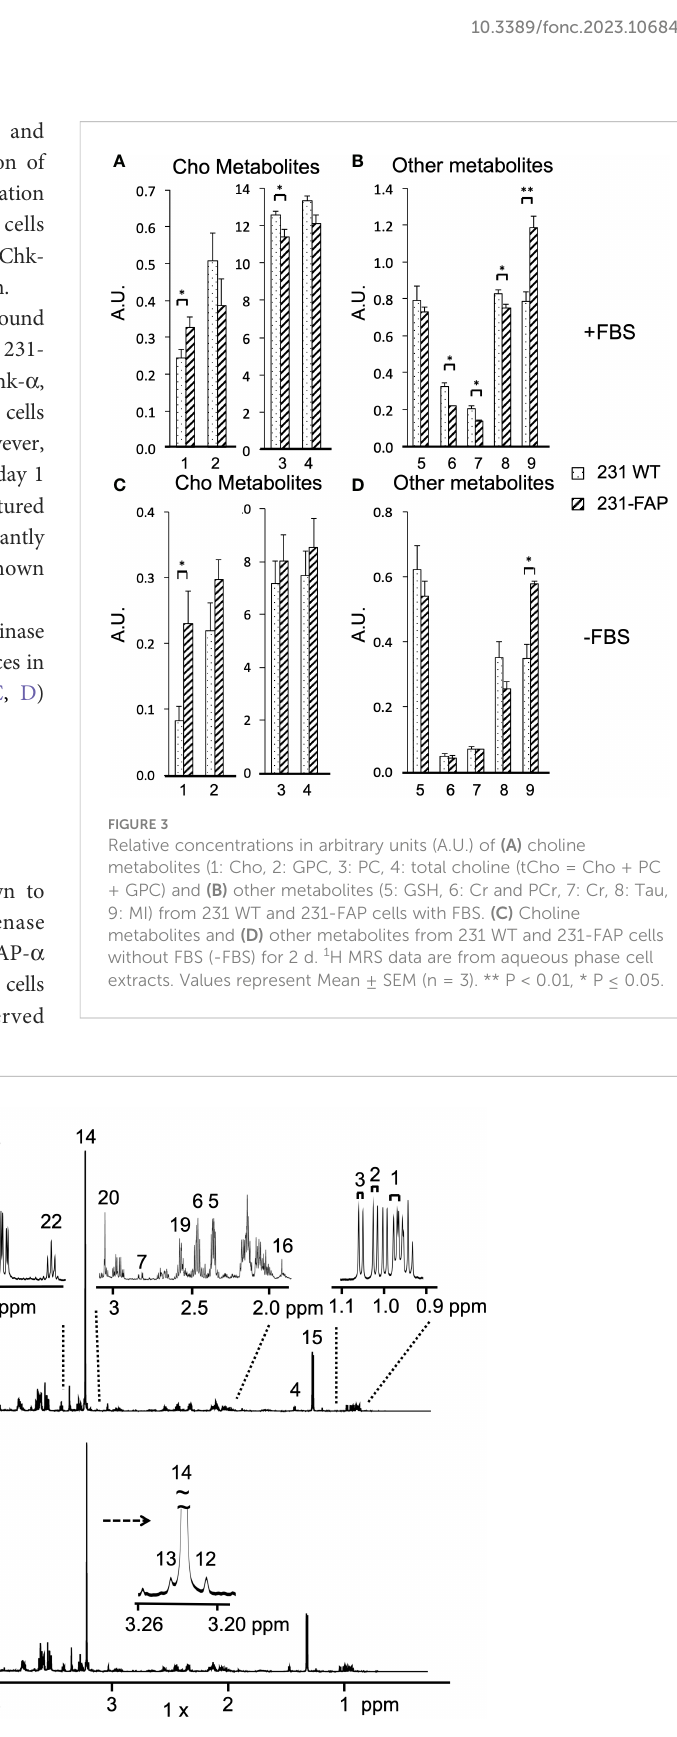
FIGURE 2 Representative 1 H MR spectra obtained from the aqueous phase of (A) 231 WT and (B) 231-FAP cells cultured with serum. The spectral region from 6.3 - 8.5 ppm was magni fi ed x15. Amino acids; 1: Leucine (Leu); 2: Isoleucine (Ile); 3: Valine (Val); 4: Alanine (Ala); 5: Glutamate (Glu); 6: Glutamine (Gln); 7: Aspartate (Asp); 8: Glycine (Gly); 9: Histidine (His); 10: Tyrosine (Tyr); 11: Phenylalanine (Phe). Choline metabolites; 12: Choline (Cho); 13: Glycerophosphocholine (GPC); 14: Phosphocholine (PC). Organic acids; 15: Lactate (Lac); 16: Acetate (Ace); 17: Fumarate (Fum); 18: Formate (For). Other metabolites; 19: Glutathione (GSH); 20: Creatine (Cr) and Phosphocreatine (PCr); 21: Cr; 22: Taurine (Tau); 23: Myo-inositol